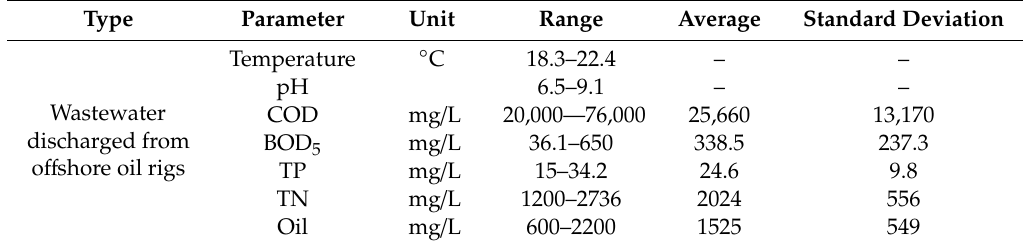
Table 1. Compositions of high-concentration oil and gas field wastewater